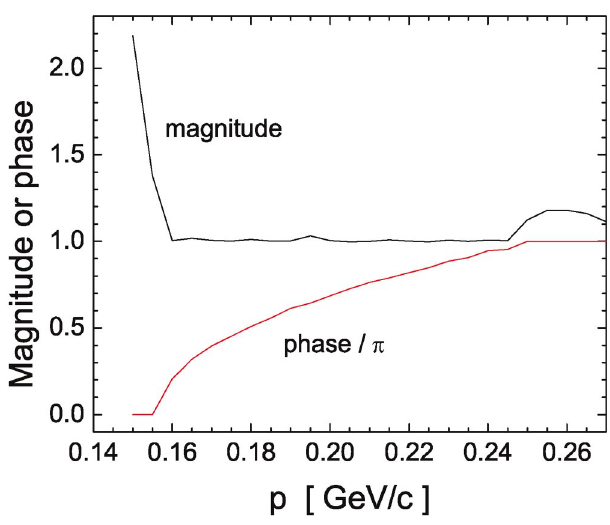
FIG. 6. (Color) Magnitude and phase of the largest eigenvalue for the one-cell transport matrix.